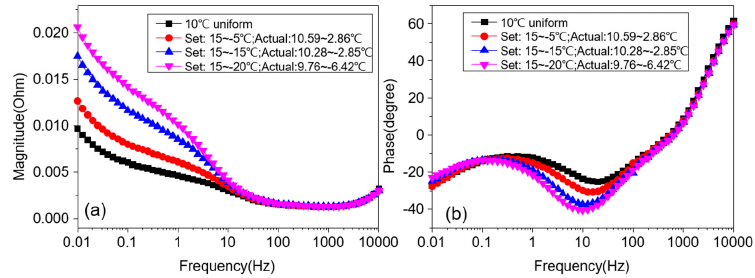
Figure 13. EIS of battery in Bode plots with different artificial temperature gradients: ( a ) impedance magnitude; ( b ) impedance phase. magnitude; ( b ) impedance phase.